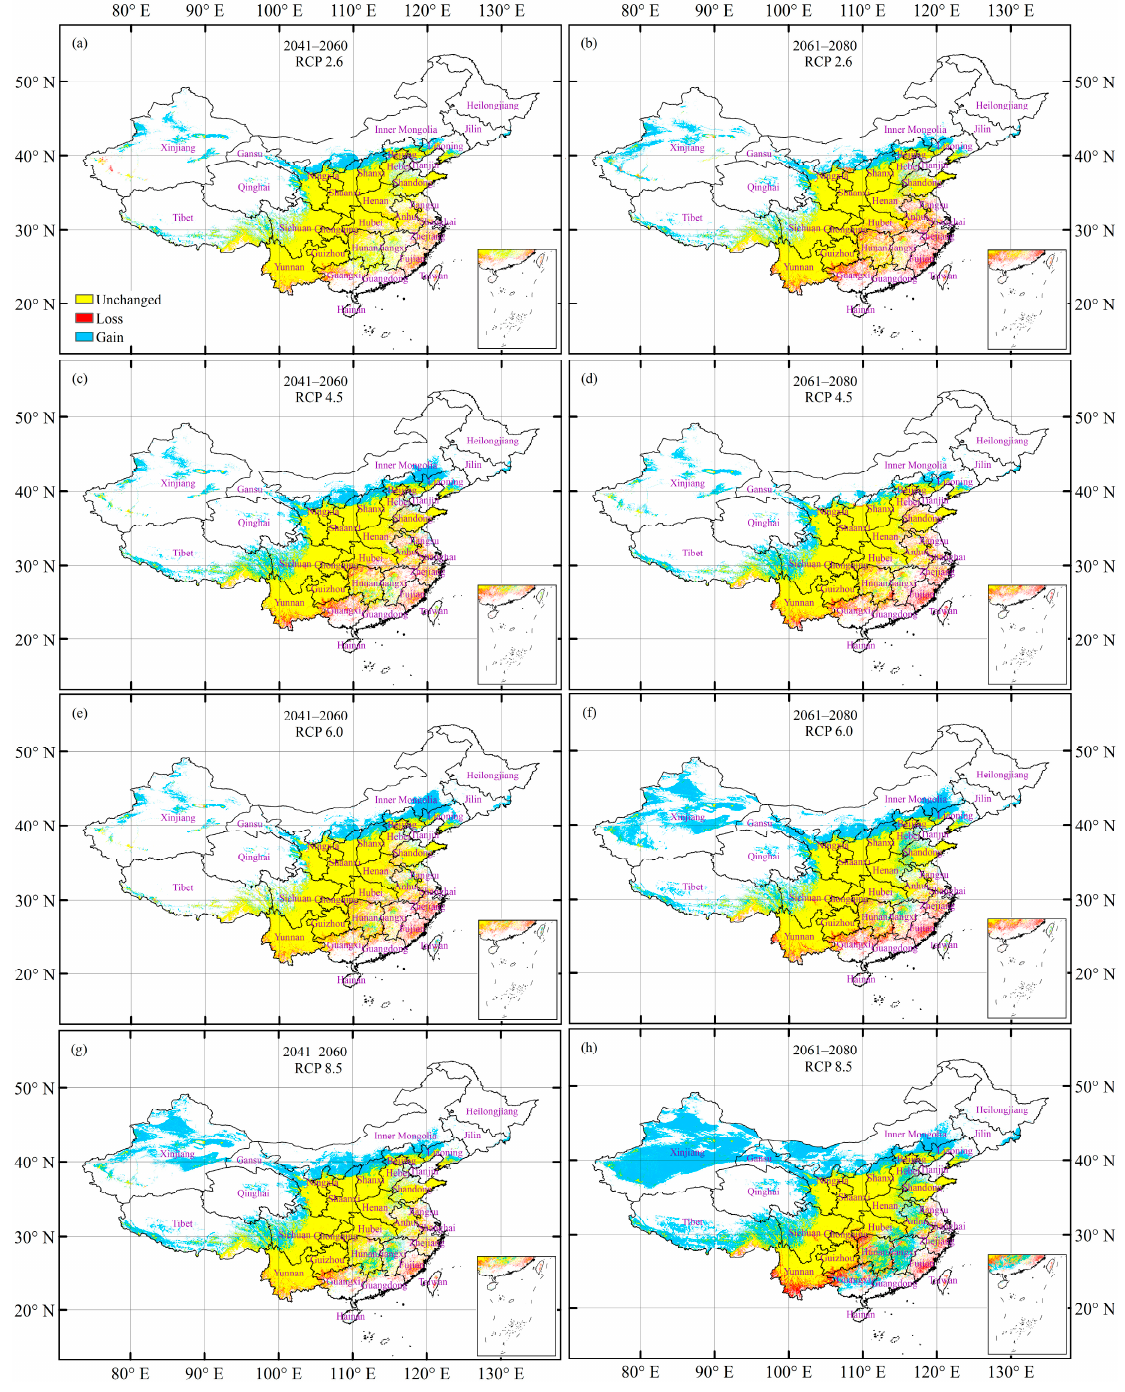
Figure 5. Changes in the climatically suitable habitat of Juglans regia under different climate change scenarios around the world. ( a ) Period of 2041–2060 in the RCP 2.6 climate scenario; ( b ) period of 2061–2080 in the RCP 2.6 climate scenario; ( c ) period of 2041–2060 in the RCP 4.5 climate scenario; ( d ) period of 2061–2080 in the RCP 4.5 climate scenario; ( e ) period of 2041–2060 in the RCP 6.0 climate scenario; ( f ) period of 2061–2080 in the RCP 6.0 climate scenario; ( g ) period of 2041–2060 in the RCP 8.5 climate scenario; ( h ) period of 2061–2080 in the RCP 8.5 climate scenario.